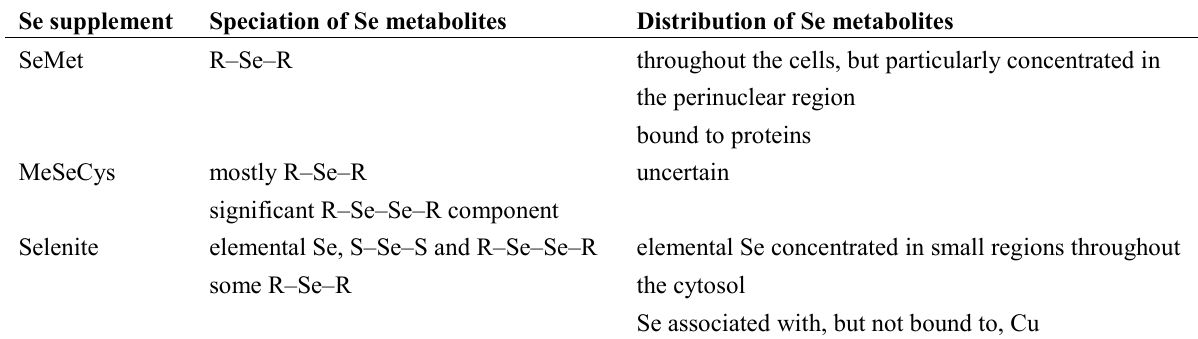
Table 1. A summary of the speciation and distribution of Se in human lung cancer cells treated with dietary Se compounds, as determined by XAS and XRF techniques